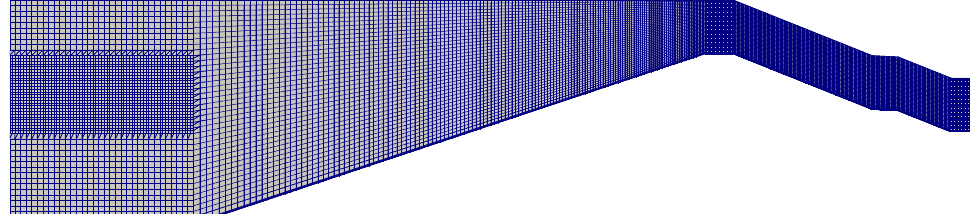
Figure 6. A section of generated mesh in OpenFOAM®, the locally refined mesh near the water surface is visible on the left. The grid cells are refined towards the crest and along the landward slope, which are the areas of